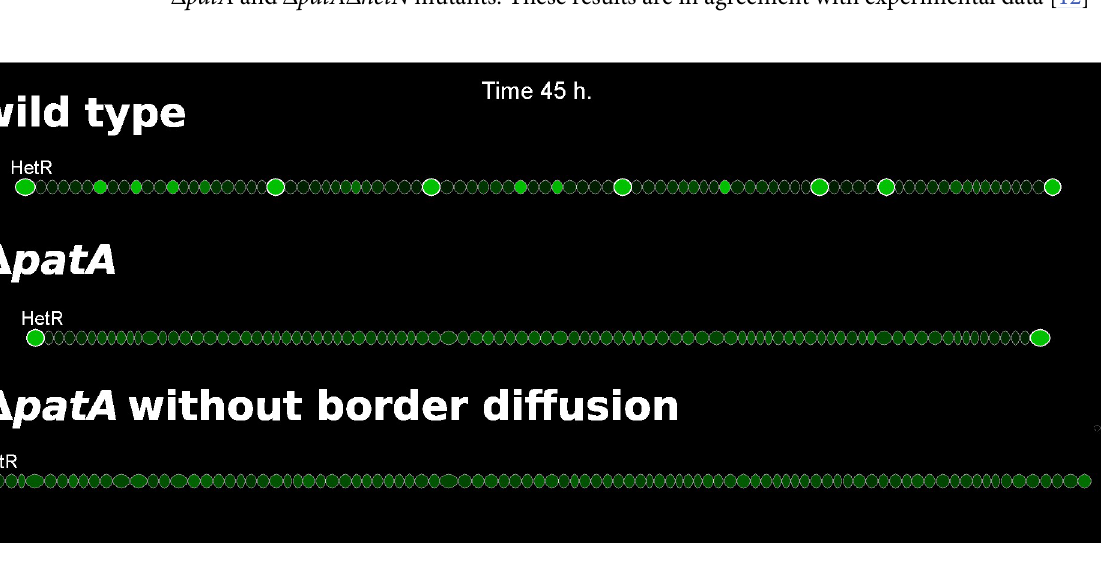
Fig 6. Three simulations showing HetR profiles in filaments of wild type, Δ patA , and Δ patA with no inhibitor leakage from the terminal cells ( d broder = 0). HetR concentration is represented by the brightness of green and the heterocysts present an additional white cell wall. For the wild type one can observe cells with high levels of HetR, candidates to differentiate into heterocysts, between existing heterocysts.